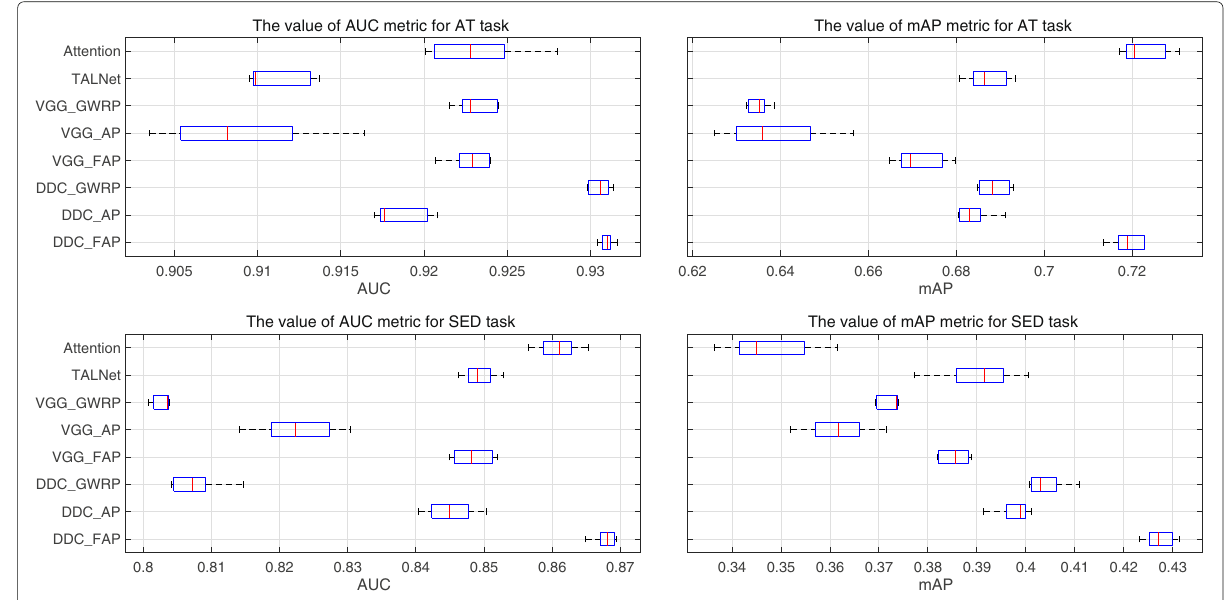
Fig. 5 The metrics box plot of the mentioned